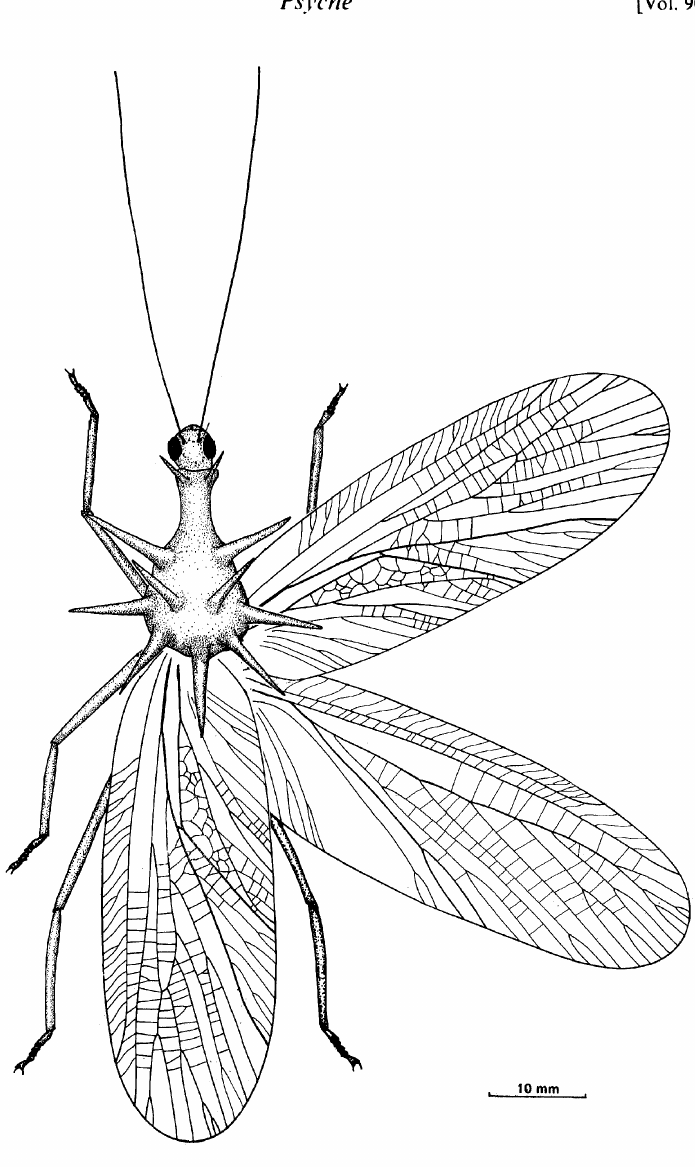
Fig. 2. Gerarus danielsi, composite drawing, based primarily on-specimens FMNH PE 5276, 31973, 32027, 32029; and USNM